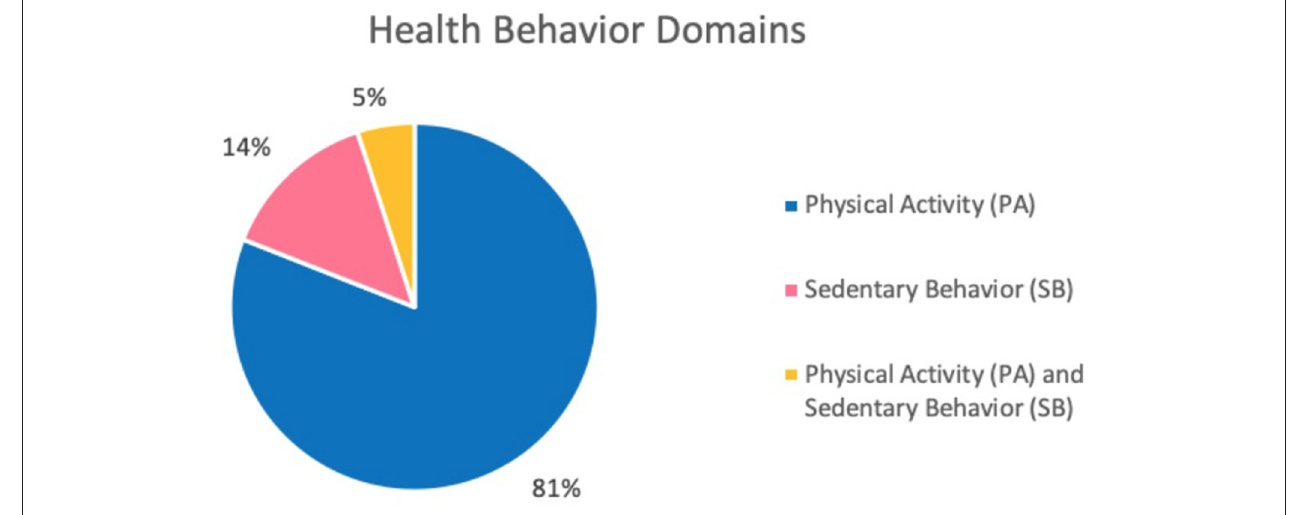
FIGURE 11 | Targeted health behavior domains.